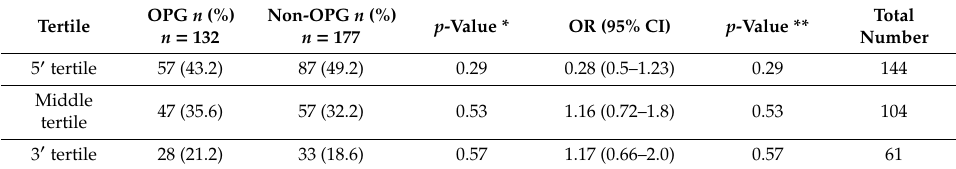
Table 2. Mutations in NF1 gene tertiles and the risk of developing OPG.